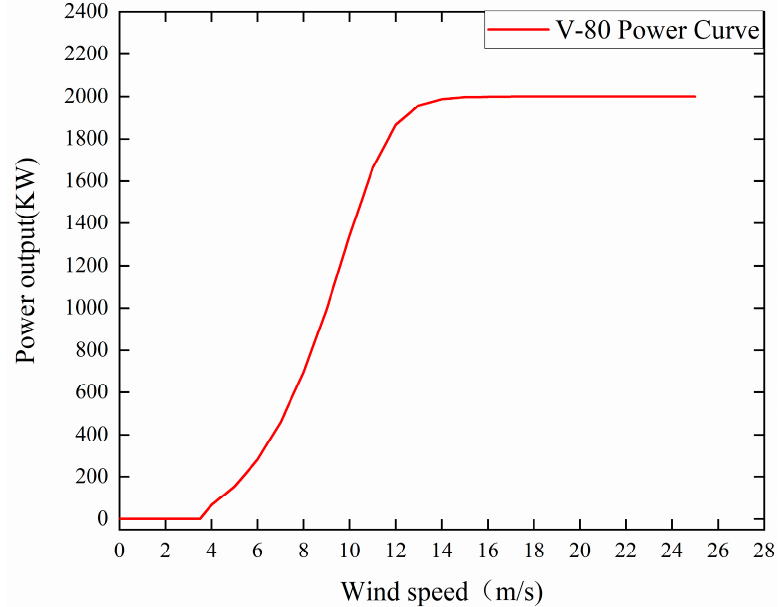
Figure 5. Power curve of the wind turbines. Table 2. Parameters of the wind turbines.